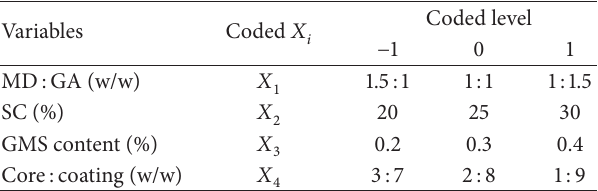
Table 2: Box-Behnken design for optimizing microencapsulation of